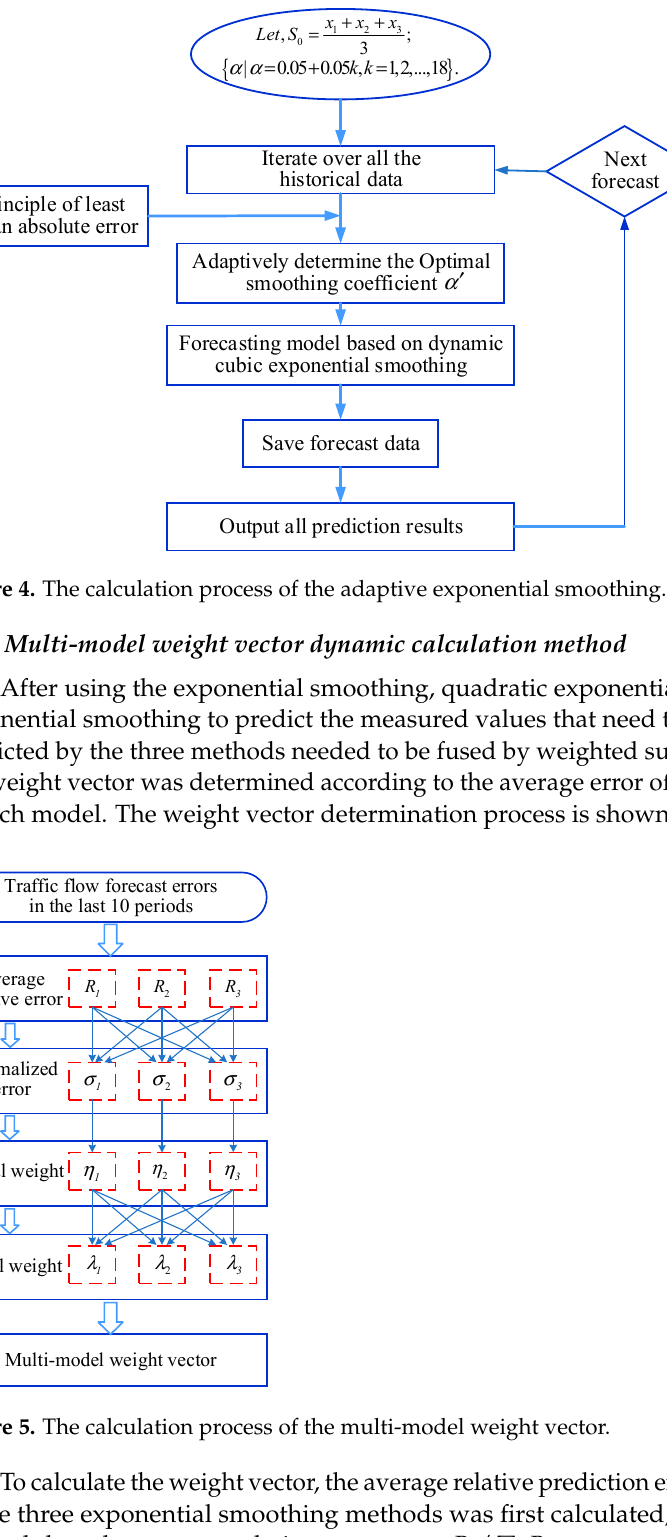
Figure 5. The calculation process of the multi-model weight vector.